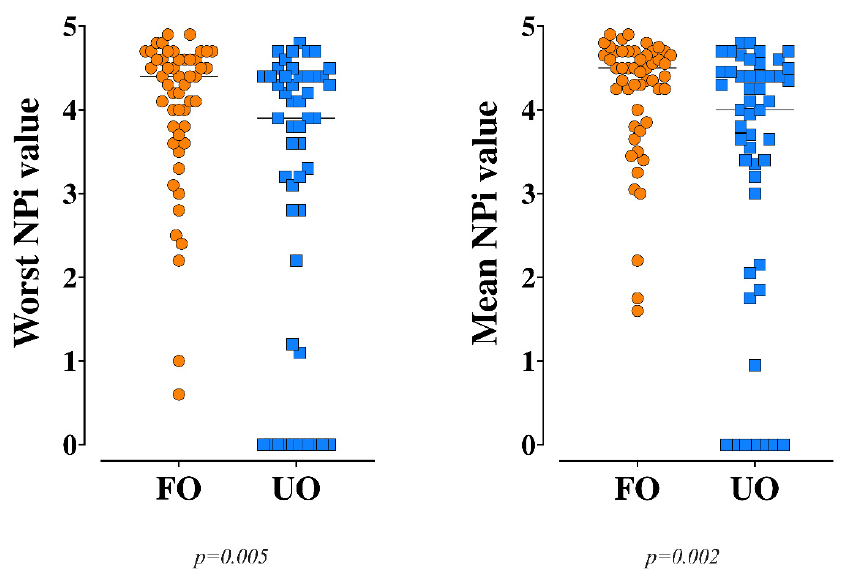
Figure 1. Worst and mean Neurological Pupil Index (NPi) on admission between patients with unfavorable (UO) and favorable (FO) neurological outcome. The Mann–Whitney U-test was used for this analysis.